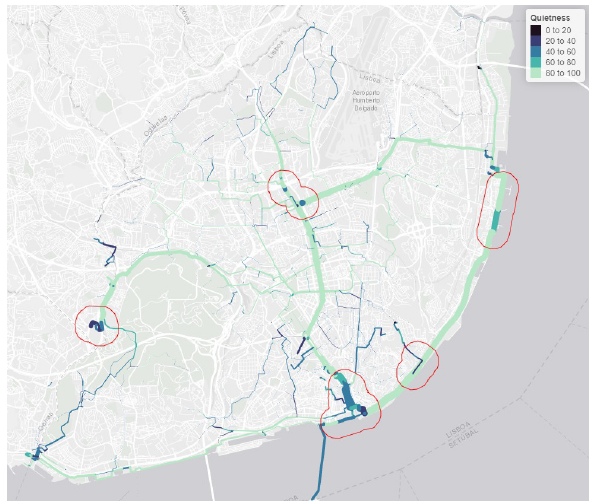
Figure 10. Segments on the transport network of Lisbon where investment in new cycling infrastructure should be prioritised according to the route networks generated using methods presented in this paper, alongside local